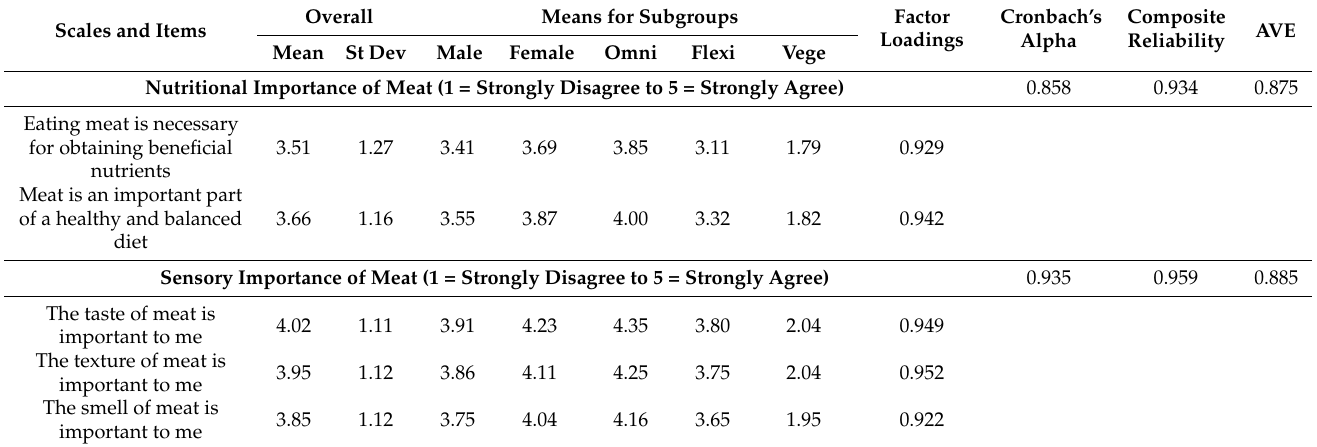
Table 3. Scale Loadings, Reliabilities, and Convergent Validity.